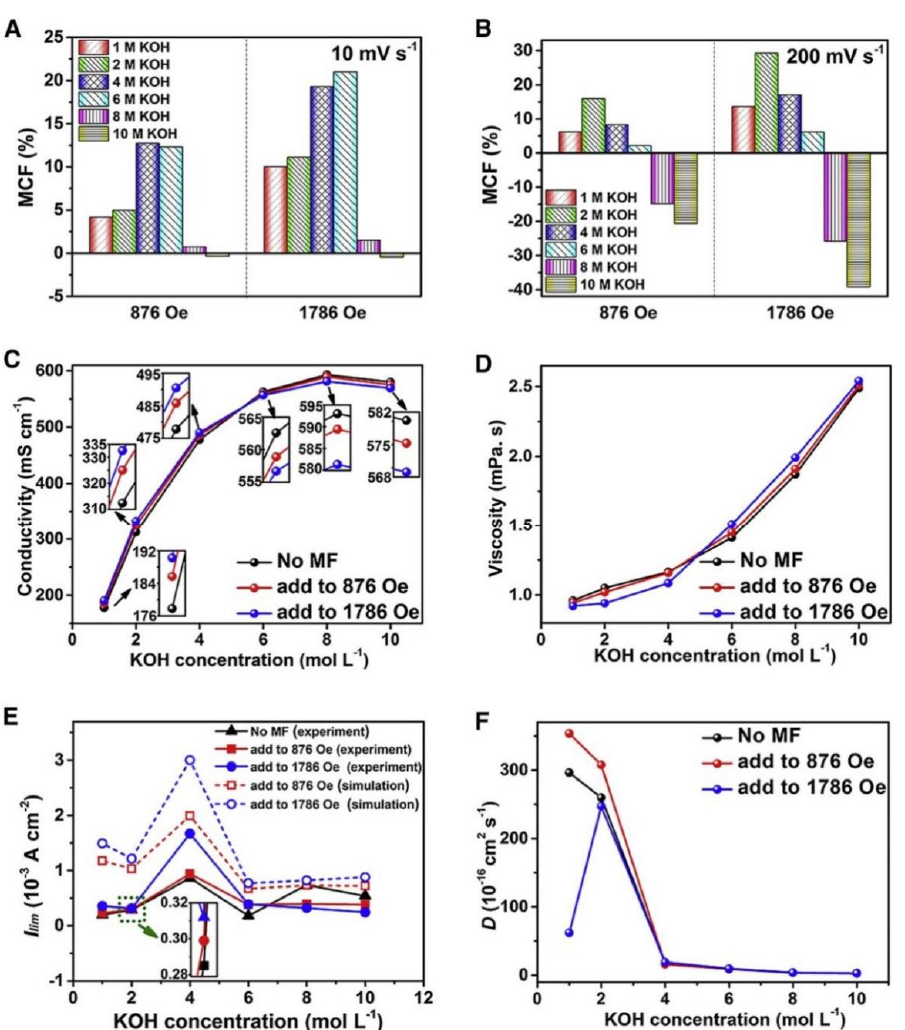
Figure 16. Influence of a magnetic field on the electrochemical properties of KOH electrolytes at various concentrations. Variation in the MCF values at a scan rate of ( A ) 10 mV/s, ( B ) 200 mV/s, ( C ) Variation in the conductivity with KOH concentrations under different magnetic field, ( D ) Variation in the viscosity with KOH concentrations under different magnetic field, ( E ) Variation if I lim with KOH concentrations, and ( F ) Diffusion coefficient of KOH with various concentrations. Reproduced (modified) from [143] Copyright (2021) with permission from Elsevier.